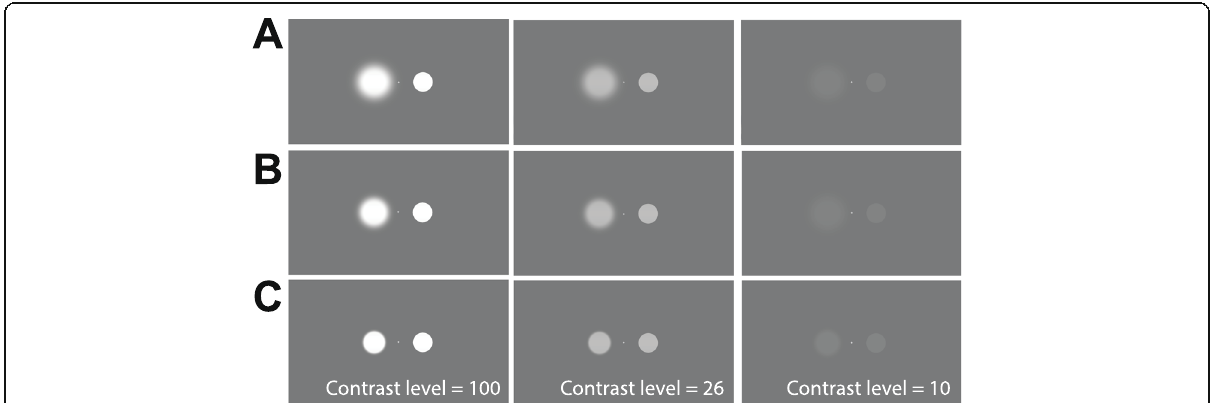
Fig. 1 A sample of the subject ’ s viewing conditions. On the rows, we can see different levels of edge filtering in which a is the higher filtering ( σ = 1.5), b is the medium filtering ( σ = 0.8), and c is the lower filtering ( σ = 0.3). From left to right columns are the samples of high, medium, and low luminance levels. The right circle with a sharped edge is the reference circle, and both circles had the same